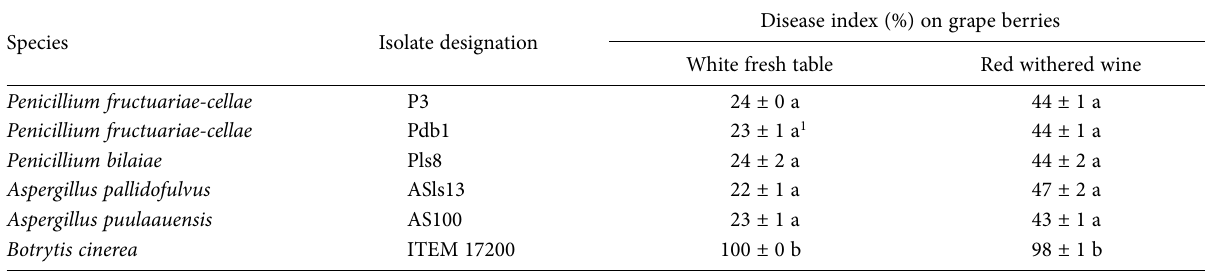
Table 4. Disease index (%) on grape berries after 14 d, for three isolates of Penicillium (P3, Pb1b and Pls8) and two of Aspergillus (ASls13 and AS100), all recovered from withered grapes, and for B. cinerea ITEM 17200 as positive control.